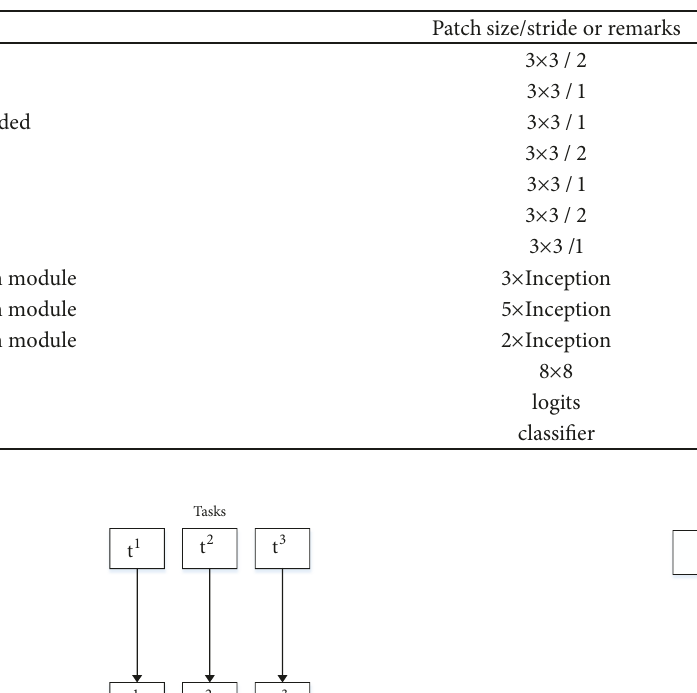
Table 1: The outline of the proposed network architecture.